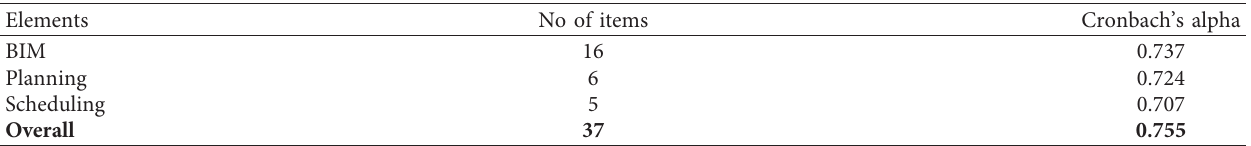
Table 2: Reliability test.